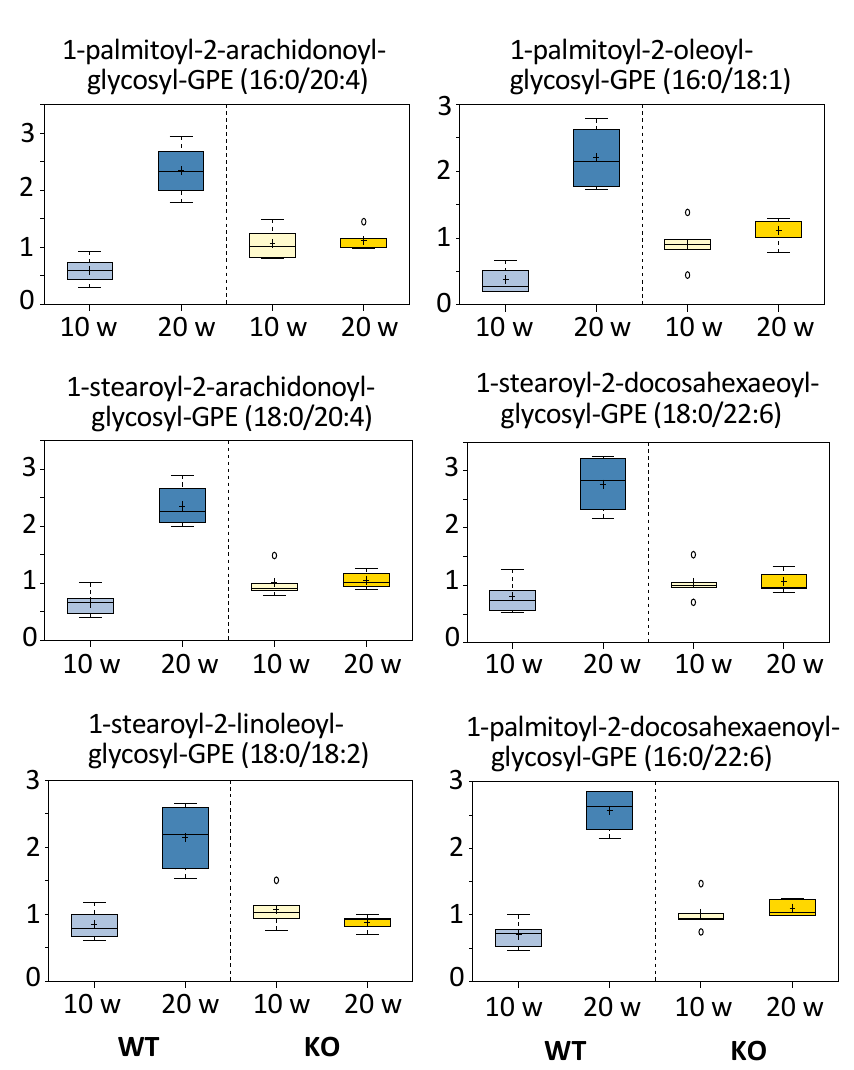
Figure 7. Comparative levels of glycosyl-GPE metabolites in the livers of DEN treated Aldh1l1 +/+ (WT) and Aldh1l1 − / − (KO) mice. Y -axes of individual metabolite box plots represent scaled intensity. Measurements for each biochemical in the original scale were rescaled to set the median equal to 1. The metabolomic analysis also indicated that the liver cells of KO mice might expe- rience stronger oxidative stress than the cells of WT mice. This conclusion is based on significantly lower levels of GSH, cysteine, and cysteinylglycine at 20 weeks post-DEN injection. Of note, oxidized glutathione (glutathione disulfide) was not different between WT and KO mice. (See Figure